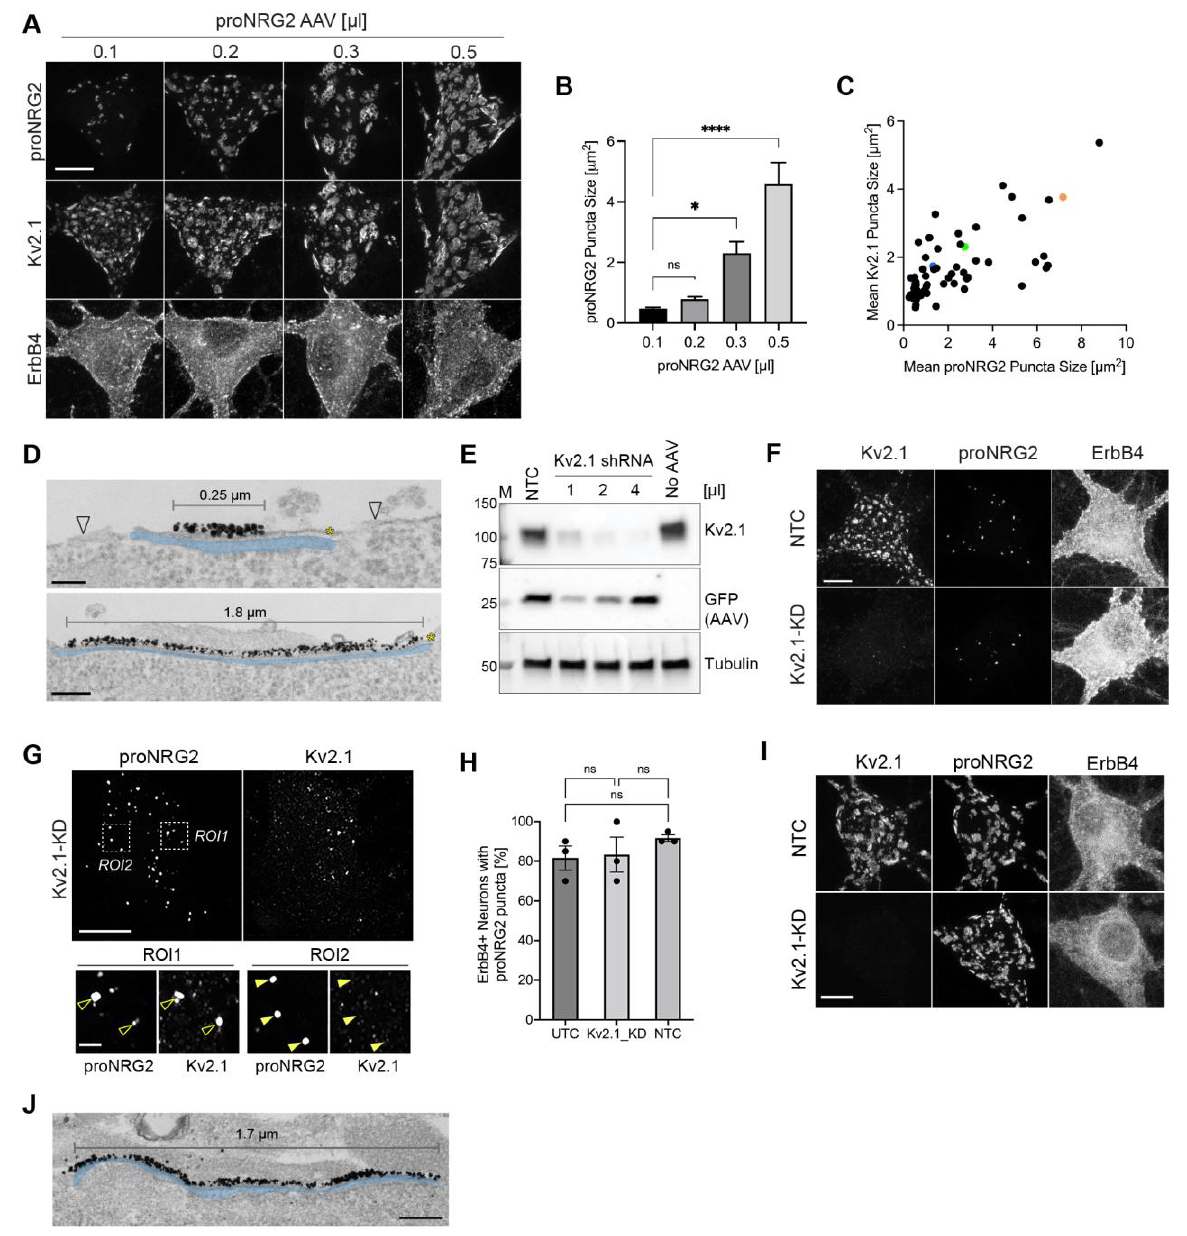
Figure 1. ProNRG2 organizes ER-PM junctions in ErbB4+ GABAergic interneurons. ( A , B ) Augmenting proNRG2 expression by AAV-mediated transduction dose-dependently increases proNRG2 cluster size without signs of diffuse surface distribution; indicated volumes are per 24-well. Note the concomitant increase in Kv2.1 cluster size that is particularly evident in the 0.5 µ L condition. ProNRG2 cluster sizes shown in ( B ) represent the mean ± SEM ( n = 713 (0.1 µ L), 1211 (0.2 µ L), 907 (0.3 µ L), 1044 (0.5 µ L) clusters from 11–13 ErbB4+ neurons per condition and two independent experiments). *, p < 0.05; ****, p < 0.0001; ns, not significant (one-way ANOVA). ( C ), Scatter plot illustrating the correlation of proNRG2 and Kv2.1 mean cluster sizes in neurons overexpressing proNRG2 ( n = 60 neurons from three independent experiments). Colored data points are from neurons shown in panel A (magenta: 0.1 µ L; blue: 0.2 µ L; green: 0.3 µ L; orange: 0.5 µ L AAV). ( D ), Representative electron micrographs showing dense patches of the proNRG2 immunogold signal at the plasma membrane (marked by asterisks) that align with the underlying SSC. The top micrograph shows a small patch of proNRG2 signal that is concentrated over the center of the SSC while sparing its periphery. This distribution resembles endogenous proNRG2 that is frequently found at the